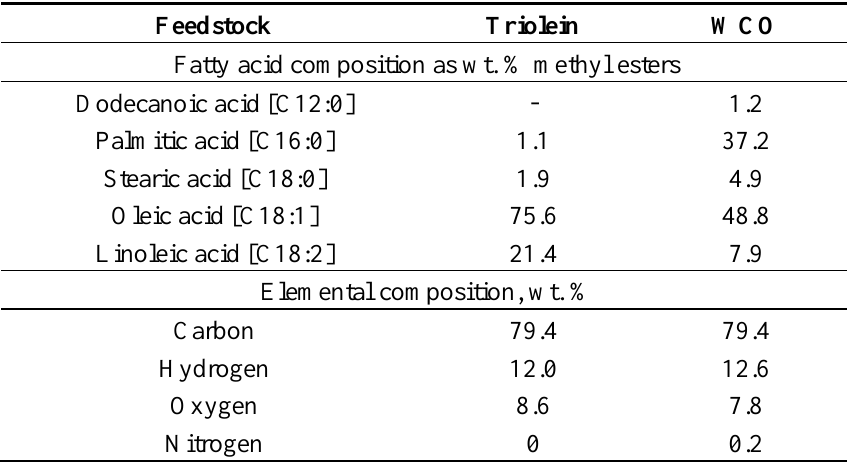
Table 2. Fatty acid and elemental compositions of technical grade triolein and waste cooking oil (WCO).